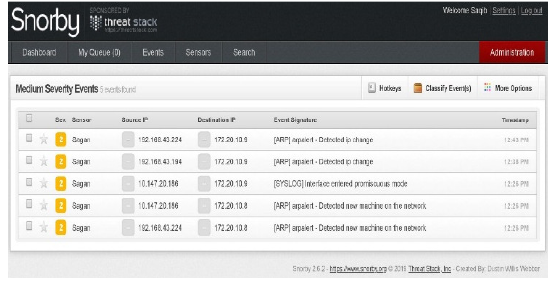
Fig. 26: Attack event packets